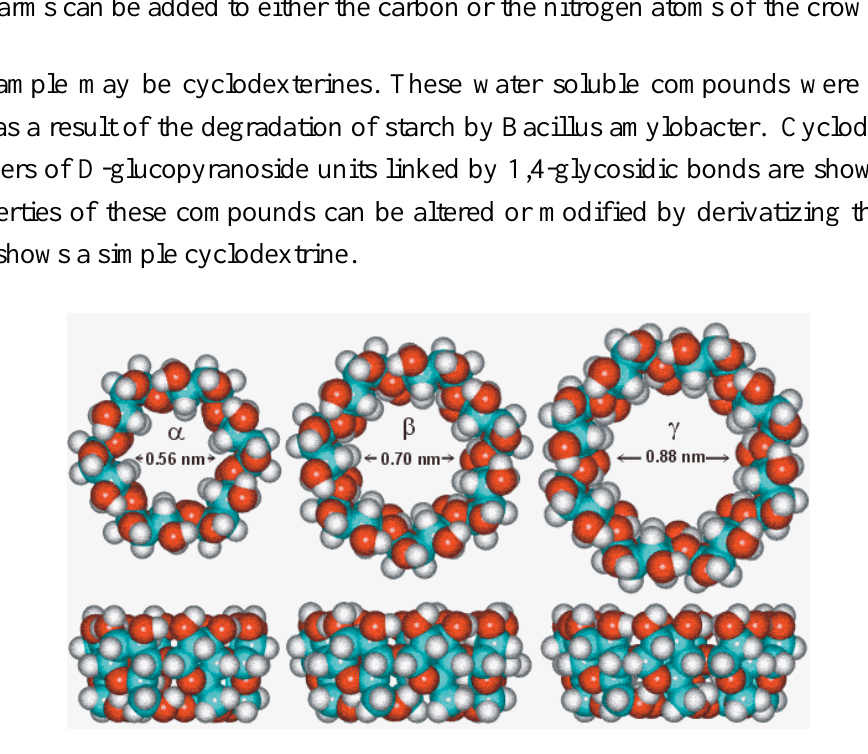
Figure 10 . Cyclodextrin and their cavities ( α =6, β =7 and γ =8 D-glucopyranoside units).